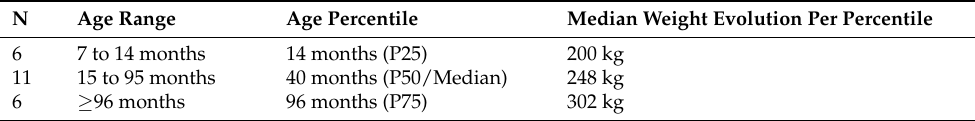
Table 1. Donkeys enrolled in the